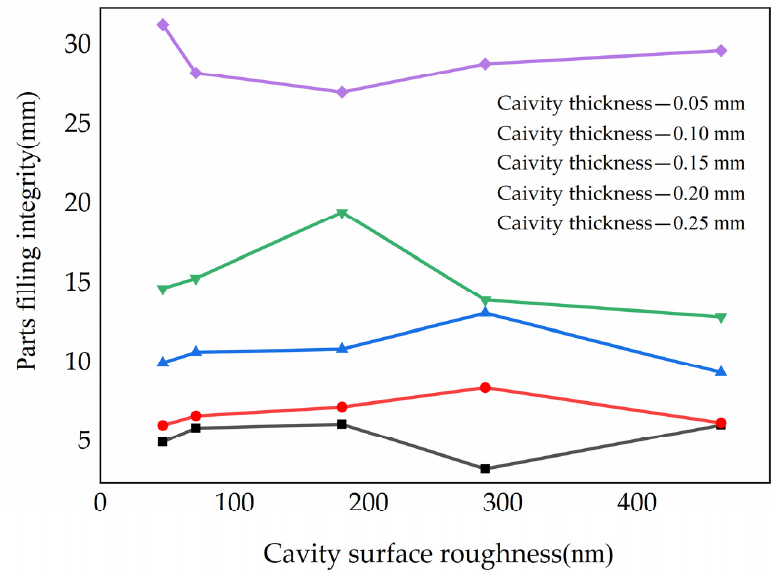
Figure 6. The filling integrity under a certain cavity thickness.